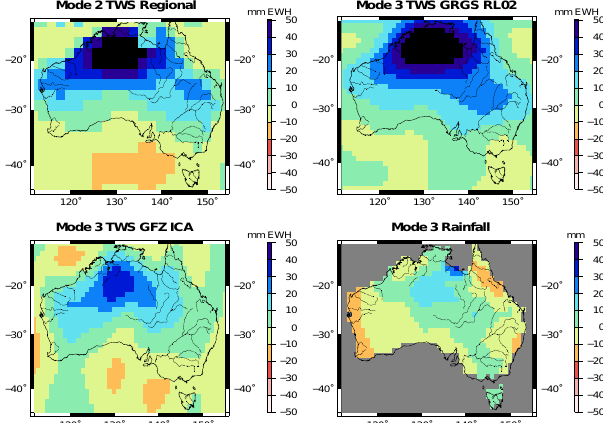
Fig. 9. (a) Temporal components of PCA 3rd orthogonal mode of regional solutions and 2nd mode of GRGS, ICA 400km-filtered solutions and Rainfall product. (b) Groundwater levels from in situ measurements over Murray-Darling Basin.